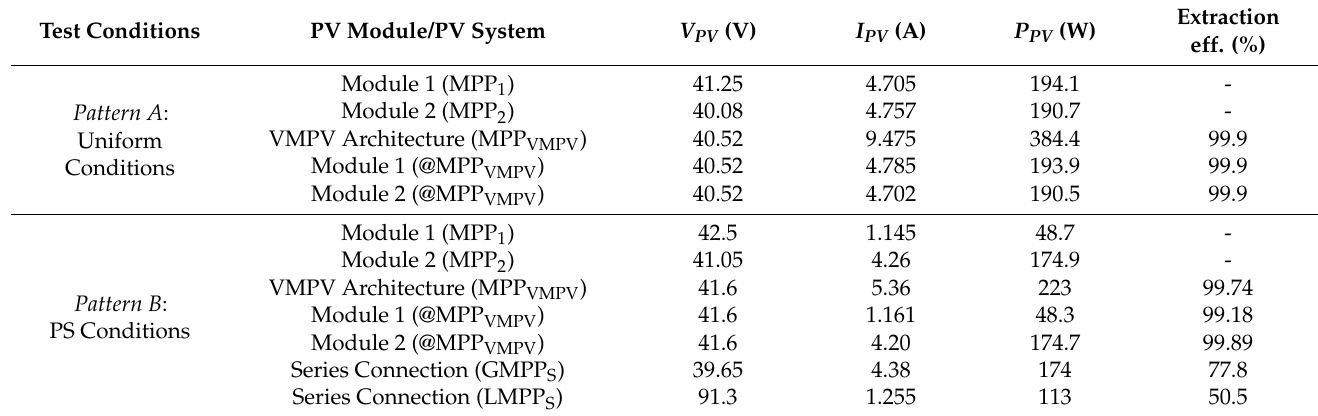
Table 2. MPP data from the experimentally extracted characteristics.